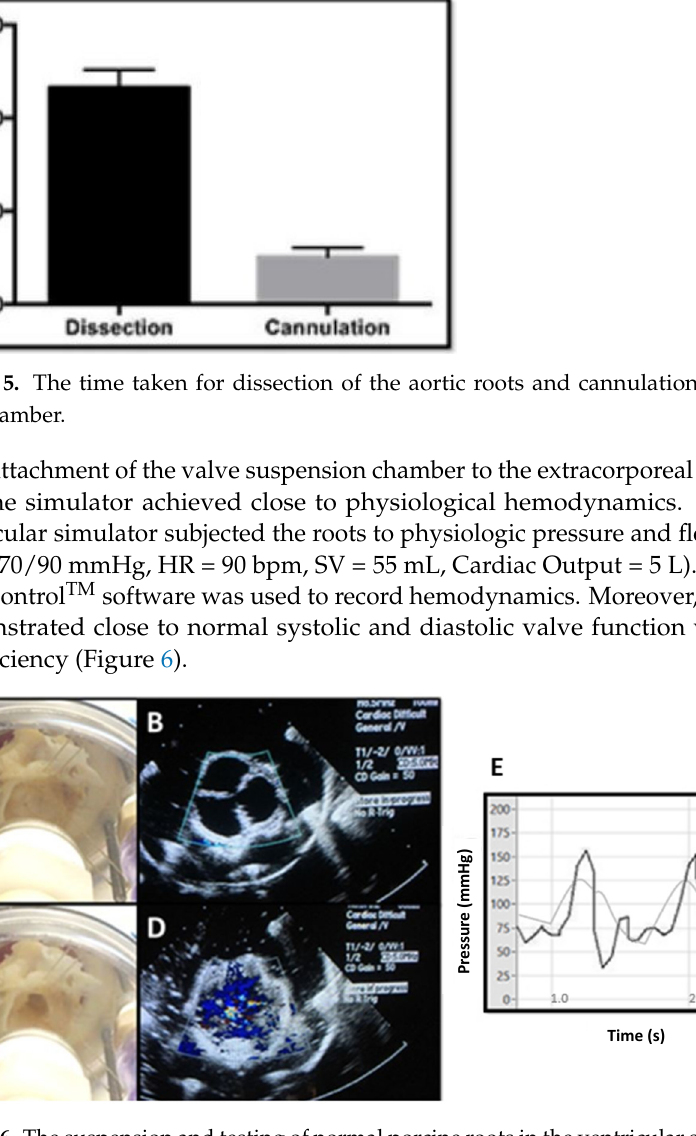
Figure 6. The suspension and testing of normal porcine roots in the ventricular simulator. ( A , B ) Visual inspection and echocardiography of the suspended valve in diastole. ( C , D ) Visual inspection and echocardiography of the suspended valve in systole. ( E ) Hemodynamic pressure measurements during two cardiac cycles. Physiologic arterial curves are shown in